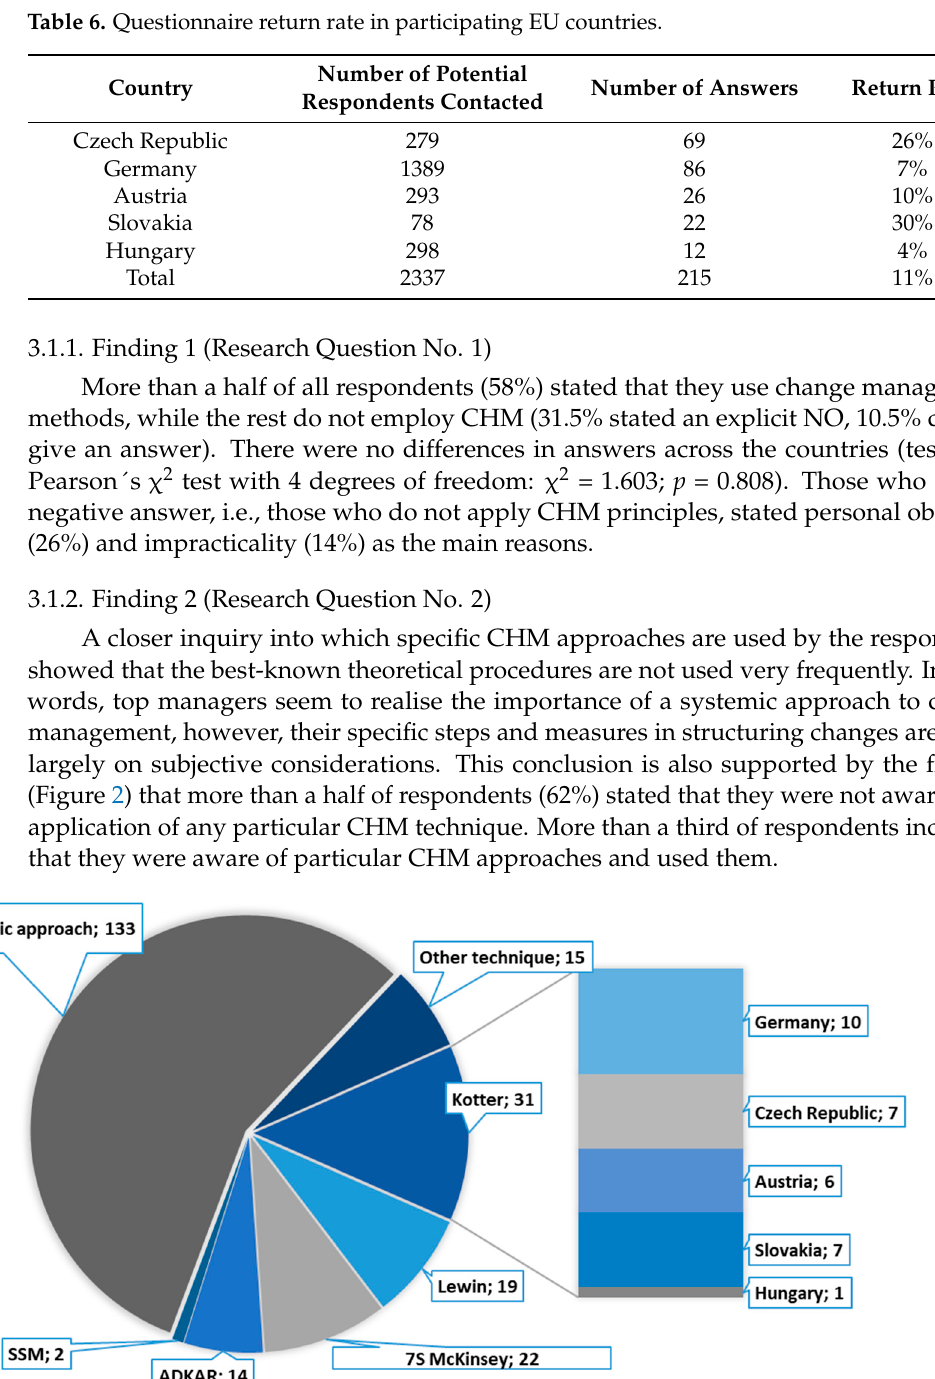
Table 7. Who is responsible for change implementation and management in the hospital. Top Management Whole Team (Leadership Coalition)